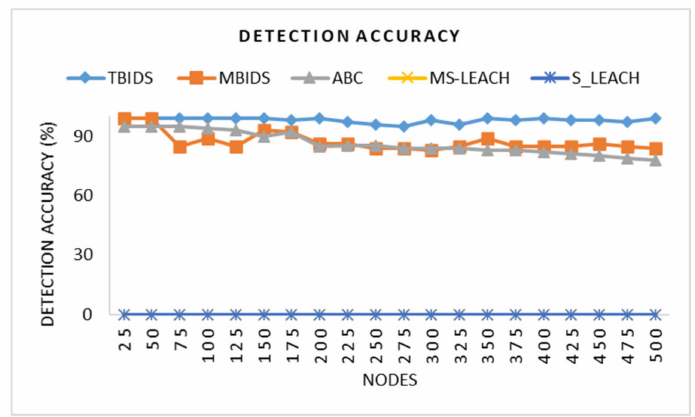
Figure 6. Single sink node and a single